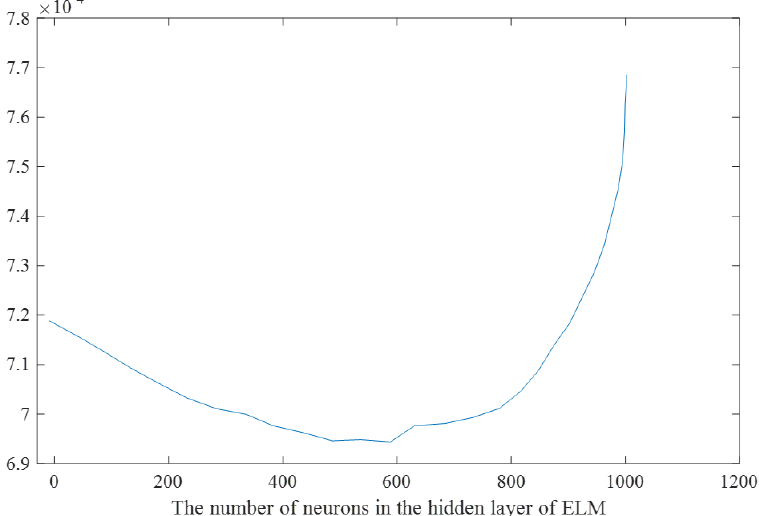
Figure 9. Relationship between the LOO calculation loss function and the number of neurons. It can be seen the best choice for the number of neurons is in the middle at about 593 hidden layer